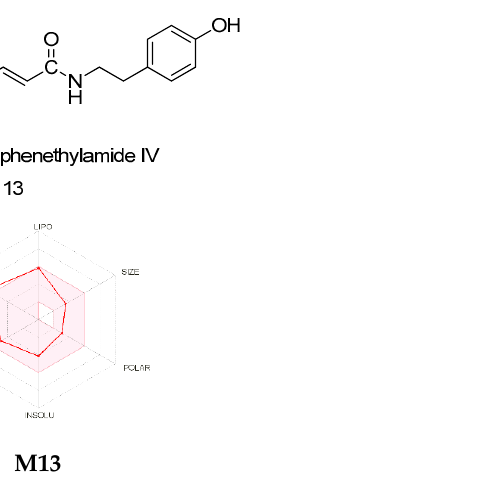
Figure 10. Radar diagrammatic representation of A. fragrantissima flower dichloromethane extract- derived identified metabolites ( M1 – M14 ) using SwissADME webserver. LIPO: Lipophilicity, Size: Molecular weight, POLAR: solubility, INSOLU: insolubility, INSATU: insaturation, and FLEX: flexibility. The properties involved in the colored zone are preferred for orally active drugs.